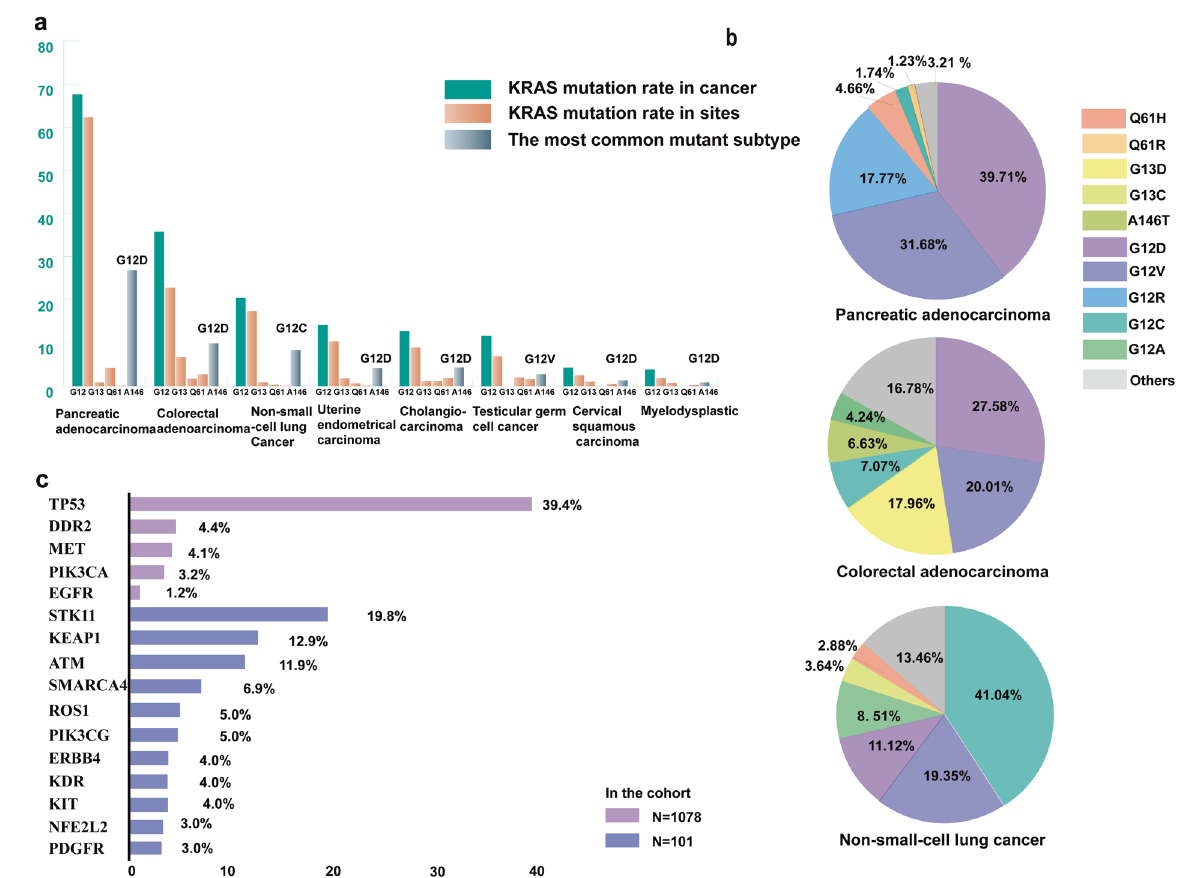
Fig. 3 KRAS mutation in cancer. a The frequency of KRAS mutations across tumour types, including the mutation frequency of common sites and the subtype with the highest mutation rate in different tumour types. KRAS mutations are characterised by single-base missense mutations, 98% of which are found at codon 12, codon 13, or codon 61. Please refer to Table 1 for speci fi c fi gures. b Speci fi c mutant subtypes and percentages were represented in the top three cancers with the highest mutation rates of KRAS including pancreatic cancer, colorectal cancer, and nonsmall-cell lung cancer. c Frequency of co-occurring aberrations in KRAS mutant cells. Only a mutant prevalence of at least 3% is shown in addition to EGFR mutation, given the important effect of EGFR mutation on NSCLC. TP53: tumour protein p53 gene; DDR2: discoidin domain receptor tyrosine kinase 2 gene; MET: MNNG HOST Transforming gene; PIK3CA: phosphatidylinositol-4,5-bisphosphate 3-kinase catalytic subunit alpha gene; STK11: serine/threonine kinase 11 gene; KEAP1: kelch-like ECH-associated protein 1 gene; ATM: ATM serine/threonine kinase gene, PIK3CG: phosphatidylinositol-4,5-bisphosphate 3-kinase catalytic subunit gamma gene; ERBB4: erb-b2 receptor tyrosine kinase 4 gene; KDR: kinase insert domain receptor gene; KIT: KIT proto-oncogene receptor tyrosine kinase gene; NFE2L2 nuclear factor erythroid 2, like 2 gene; PDGFR previous symbol of PDGFRB (platelet-derived growth factor receptor beta gene). Data acquired from The Cancer Genome Atlas (pan-Cancer) from